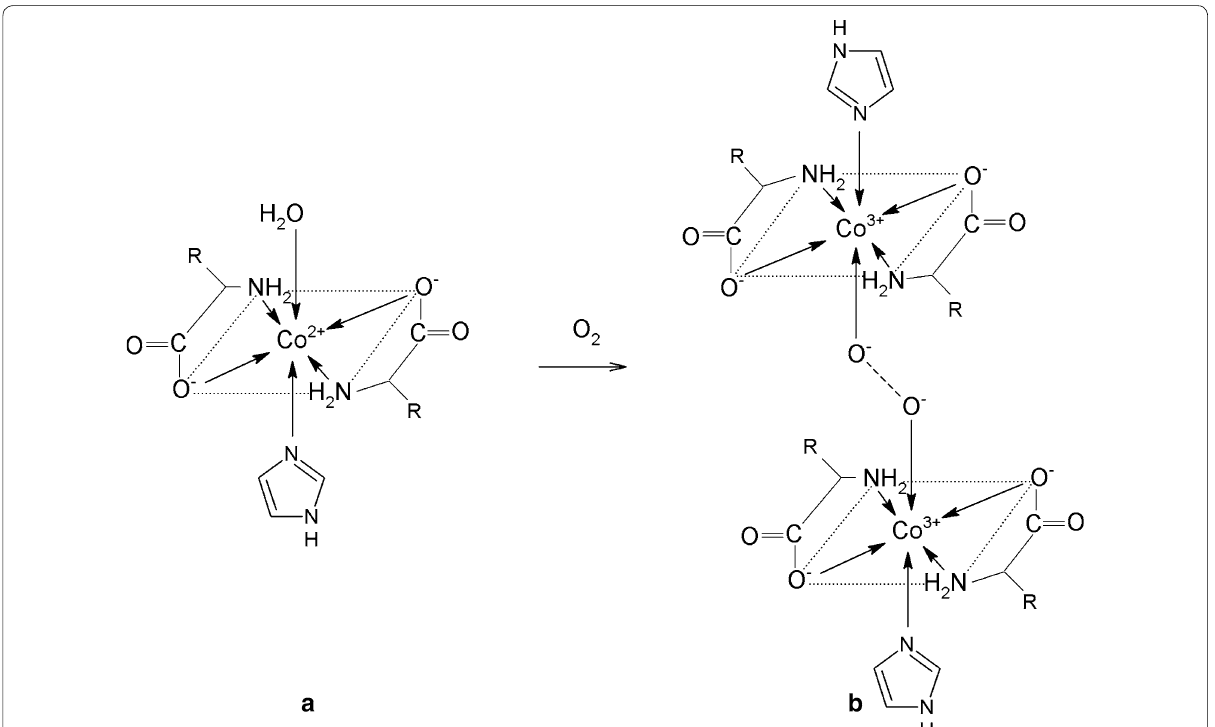
Fig. 4 Coordination modes in the Co(II)–amac–Himid system with amac plex CoL 2 L ′ , where L amac, L ′ Himid, b dioxygen